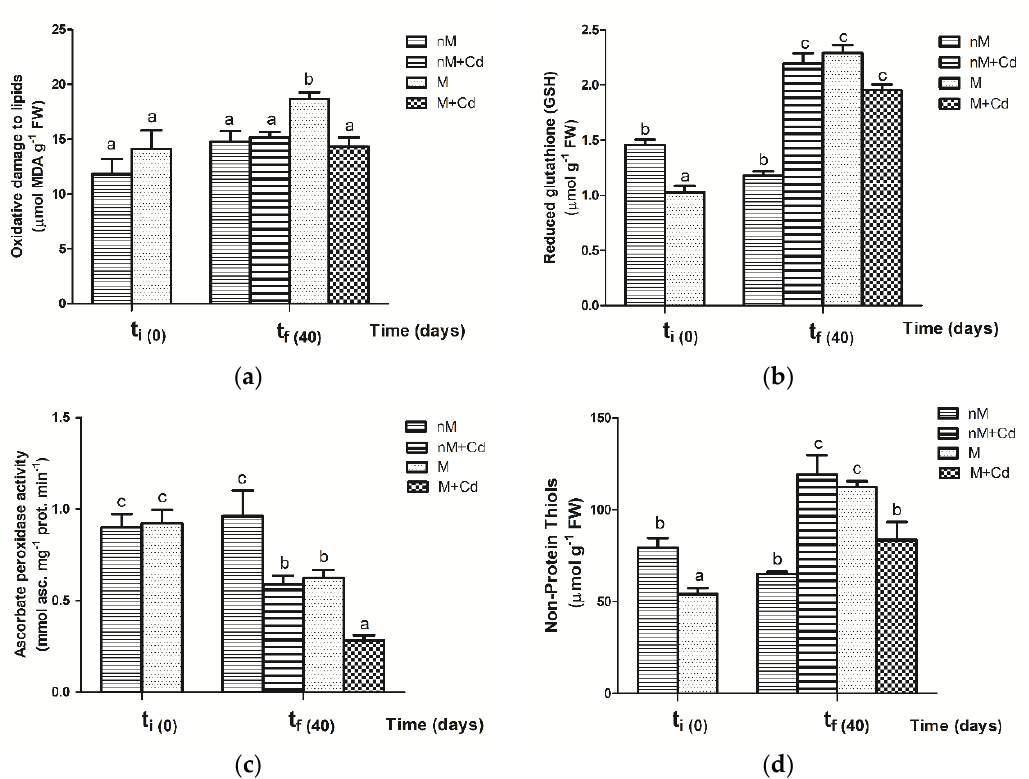
Figure 2. Effect of Cd stress on ( a ) oxidative damage to lipids [malon-di-aldehyde (MDA) content]; ( b ) glutathione (GSH) content; ( c ) peroxidase (APX) activity; ( d ) non-protein thiols (NPTs) content in leaves of non-mycorrhizal (nM) and mycorrhizal (M) soybean plants inoculated with Rhizophagus intraradices at initial time (t0) and after 40 days (tf) of Cd exposure. Data are the means of six replicates ± SE for each dependent variable. Different letters indicate significant differences at p ≤ 0.05 using a two way ANOVA to the least significant difference (LSD) post hoc test between treatments.